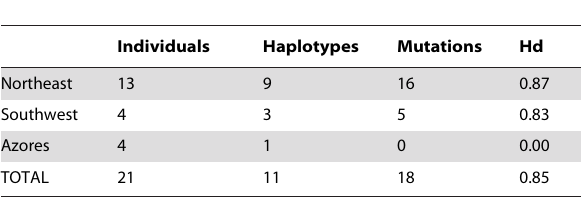
Table 1. Variation in Taenia pisiformis CO I sequences. Table 2. Genetic diversity of Taenia pisiformis